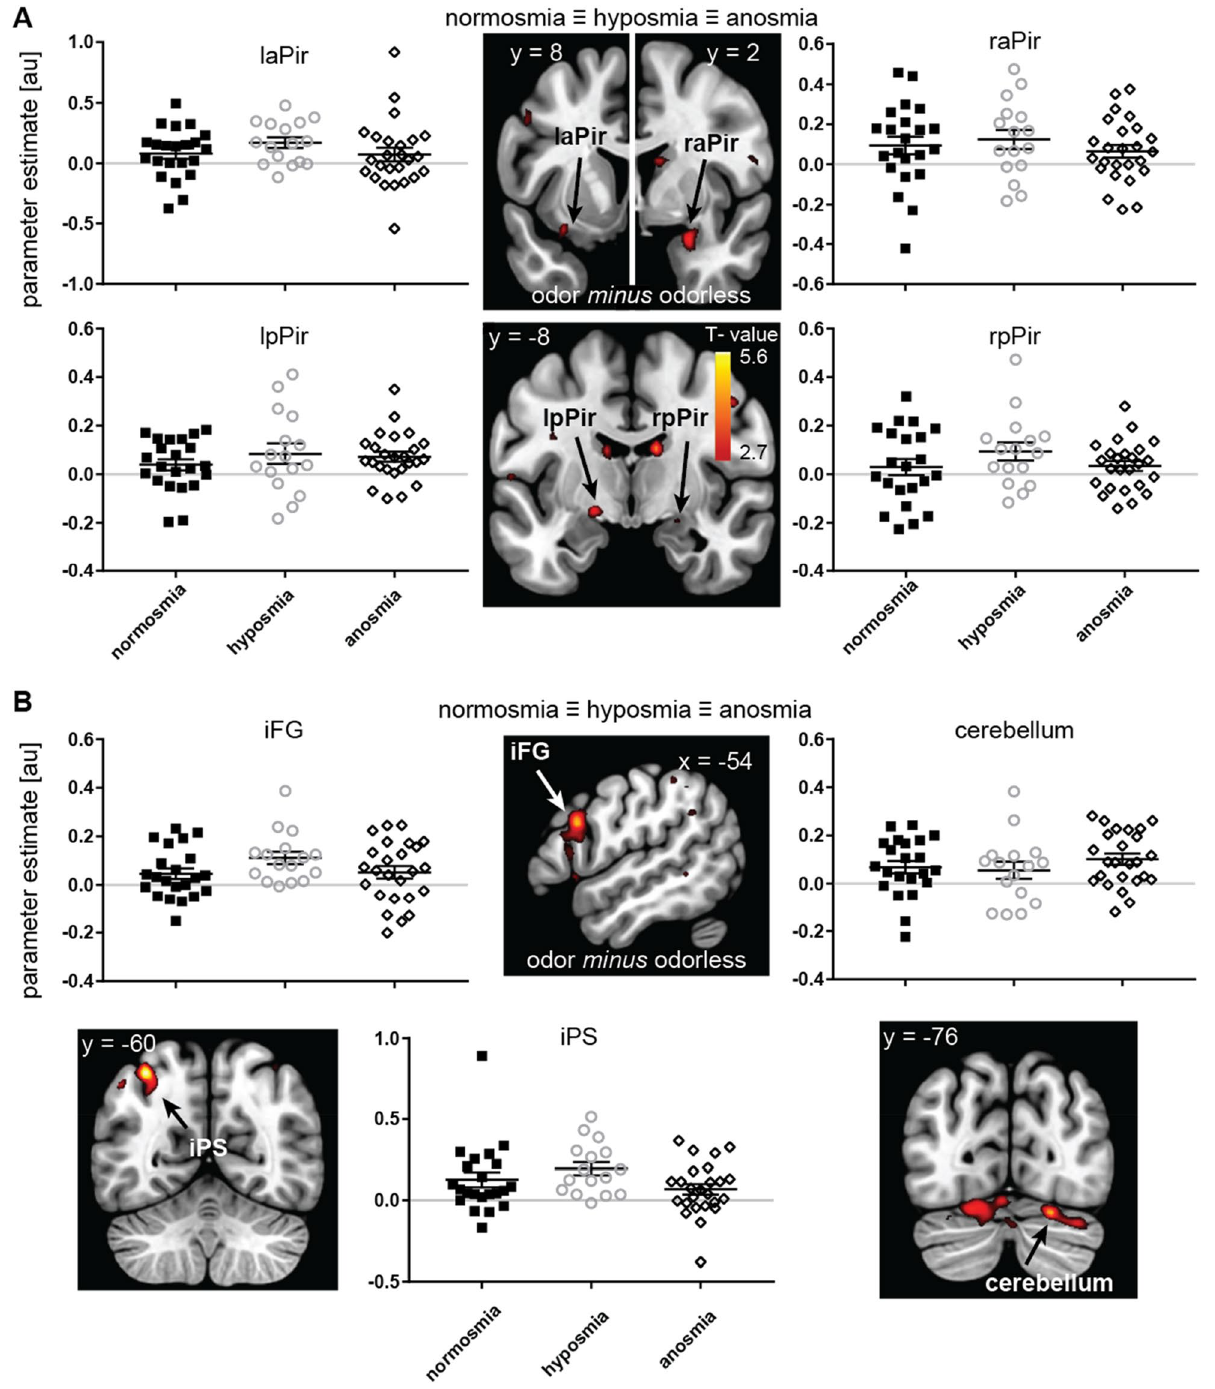
Figure 5. Neural response to odor-odorless regardless of olfactory impairment, ( A ) in a ROI of piriform cortex, and ( B ) in unpredicted regions. Sections (slice location indicated in MNI-coordinate) show canonical anatomical template with SPM T-map overlaid, thresholded at p uncorrected < .005, and a minimum of 5 contiguous voxels. Color gradient scale depicts supra-threshold T values. Graphs show parameter estimates (in arbitrary units) for the voxel with the peak t value in the cluster on the y-axis. For illustrative purposes we plotted a line through y = 0, to illustrate that, on average, each group shows positive neural response to odor vs odorless in anterior and posterior piriform (aPir and pPir), inferior frontal gyrus (iFG), intra parietal sulcus (iPS) and cerebellum. Legend details as in Fig.